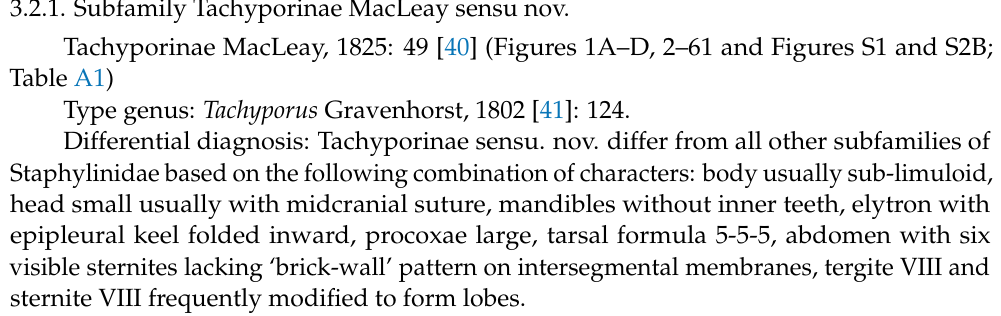
Type genus: Tachyporus Gravenhorst, 1802 [41]: